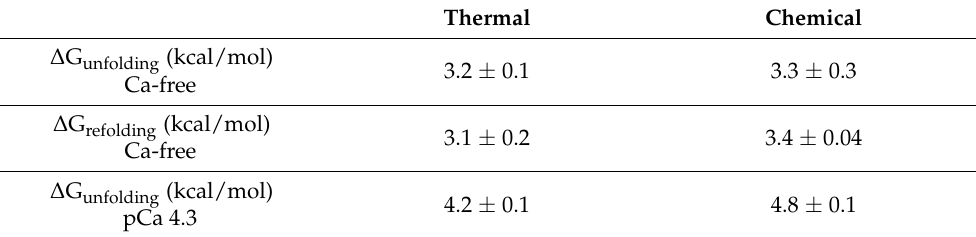
Figure 1. Thermal and chemical unfolding of I83 yield similar free energies and calcium stabilization. ( A ) CD data obtained by thermal melt for I83 ( ○ ) is fit by a two ‐ state unfolding model (solid line) with a thermal midpoint (T m ) of 53.2 °C. ( B ) Center of mass calculated from tryptophan fluorescence spectra measured during chemical unfolding ( ○ ) is fit by a two ‐ state unfolding model, with a midpoint ([Urea] 50% ) of 3.2 M. Error bars show ± one standard deviation. ( C ) Thermal unfolding fit of I83 in the absence of calcium (black) is overlayed with the unfolding fit at pCa 4.3 (dashed gray line). ( D ) Chemical unfolding fit of I83 in the absence of calcium (black) is overlayed with the unfolding fit at pCa 4.3 (dashed gray line). Reprinted from Reference [4]. Table 1. Free energy values indicated similar values for thermal and chemical unfolding and